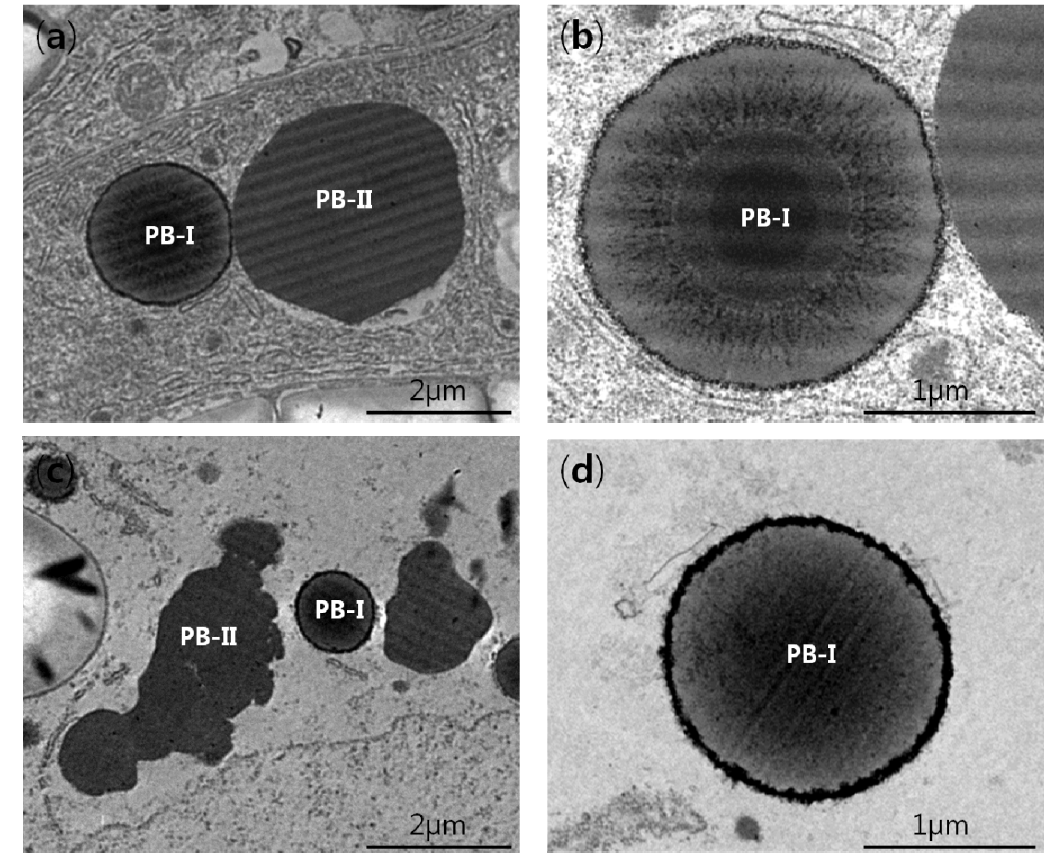
Figure 4. Transmission electron microscopy images of sub-aleurone layer cells at two WAF for the wild type (WT; a and b ) and the 13 kD pro-RNAi line 5-2 ( c and d ). PB-I is spherical and had a lamellar structure which is rich in prolamins. In contrast, PB-II is irregular with no lamellar structure which is rich in glutelins and α